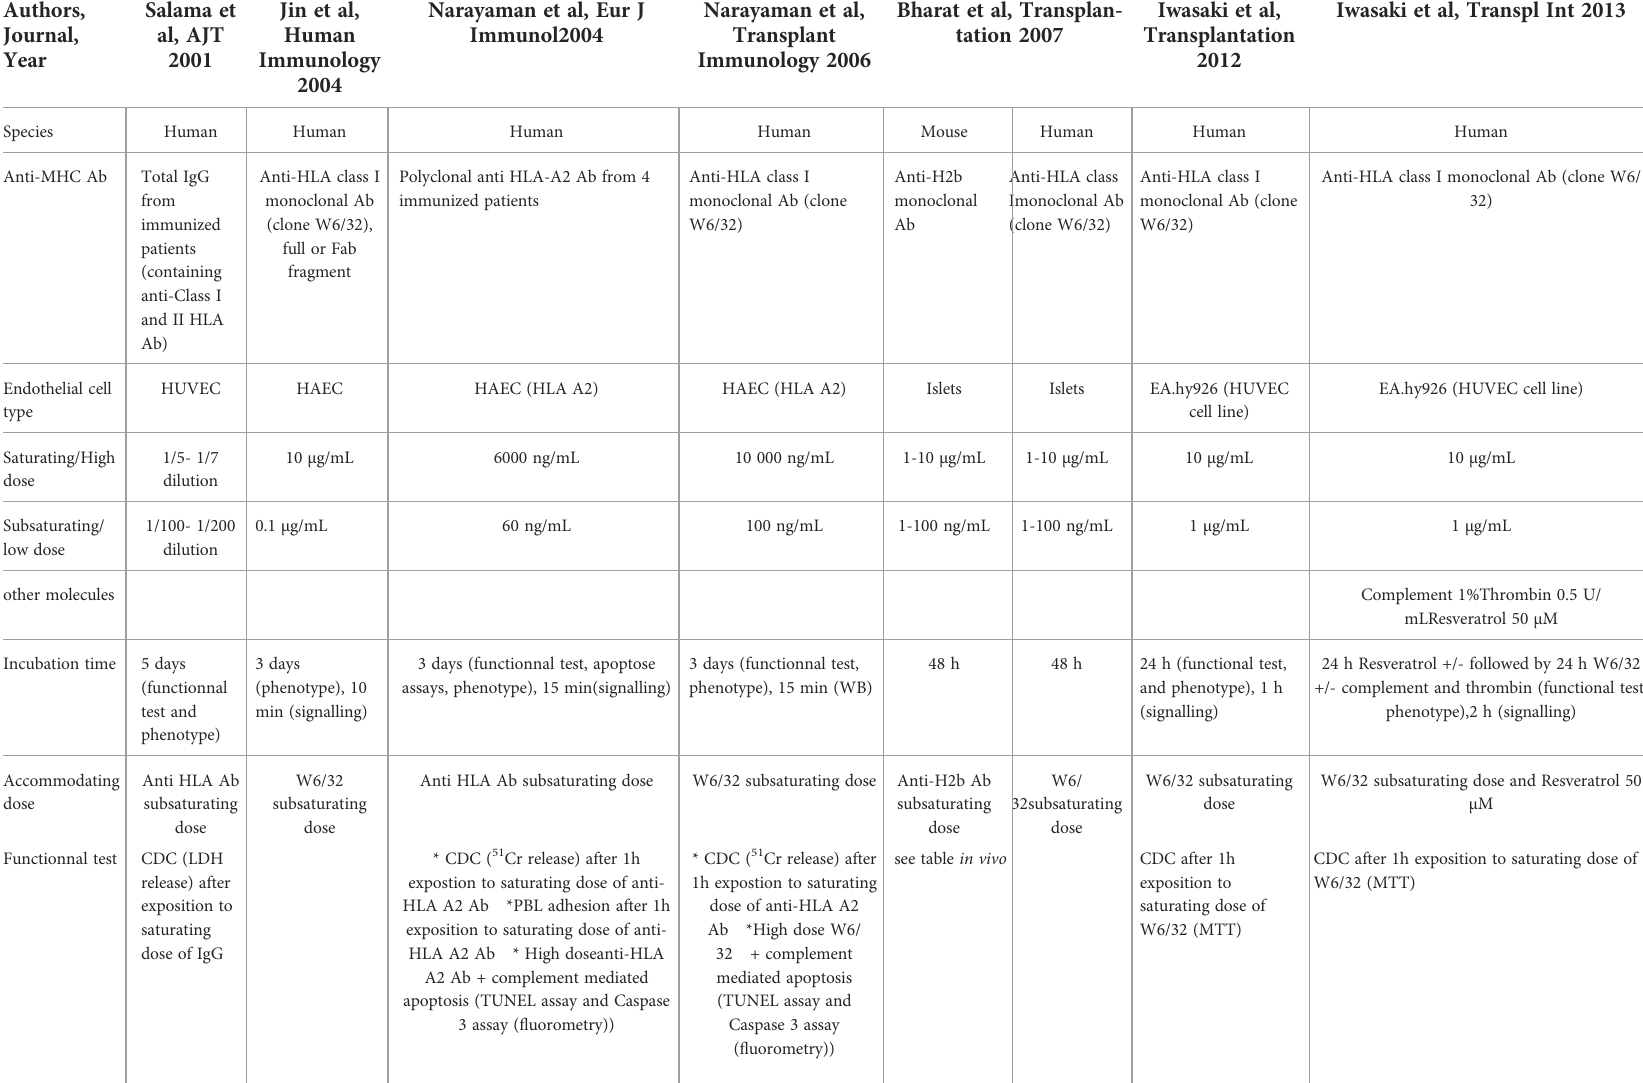
TABLE 1 In vitro induction of accommodation in anti-HLA Ab